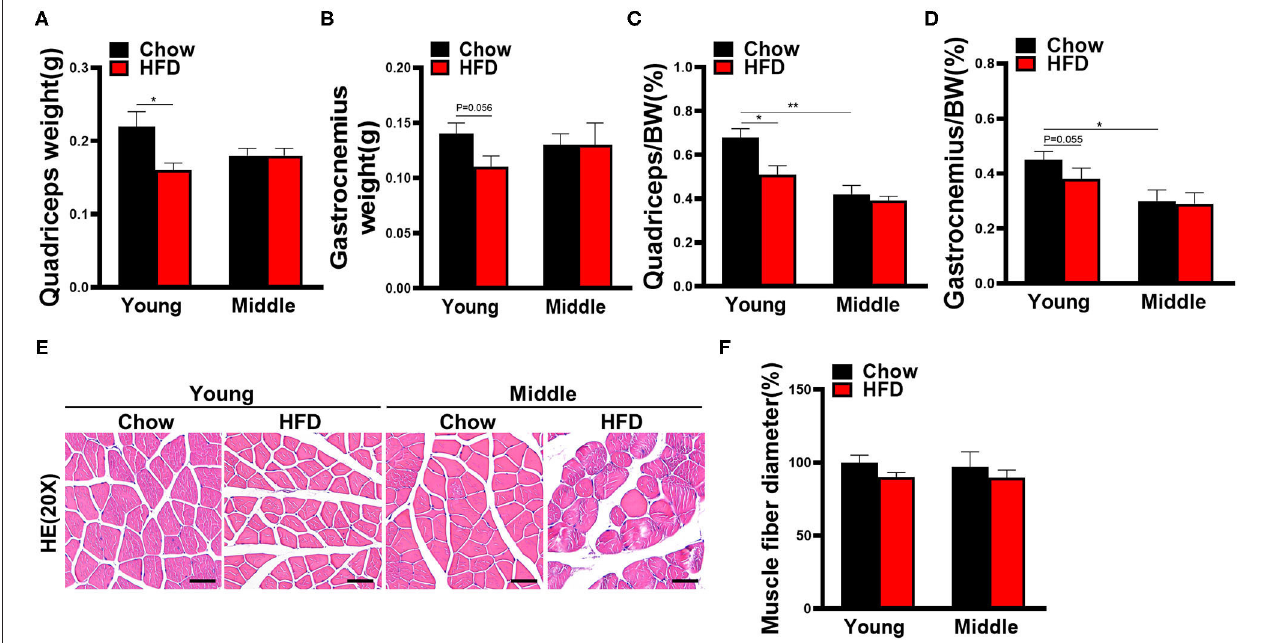
FIGURE 2 | Muscle weight and histological changes of mice fed with HFD for 12 weeks. (A) Quadriceps and (B) gastrocnemius muscle weight in mice ( n = 3–5). (C) Quadriceps weight or (D) gastrocnemius weight as a percentage of total body weight are calculated ( n = 3–5). (E) Representative hematoxylin and eosin staining of quadriceps in mice ( n = 3–5) are shown (scale bar, 50 µ m). (F) Quantification of mean muscle fiber diameters was performed by Image J software ( n = 3–5). The data are presented as the mean ± SEM, unpaired two-tailed Student’s t -test. * P < 0.05, ** P <